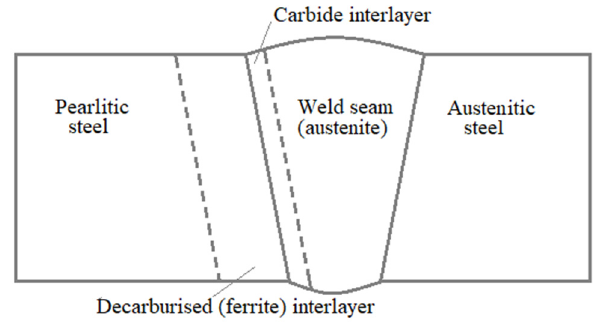
Figure 1. Scheme of a welded joint of pearlitic and austenitic steels.